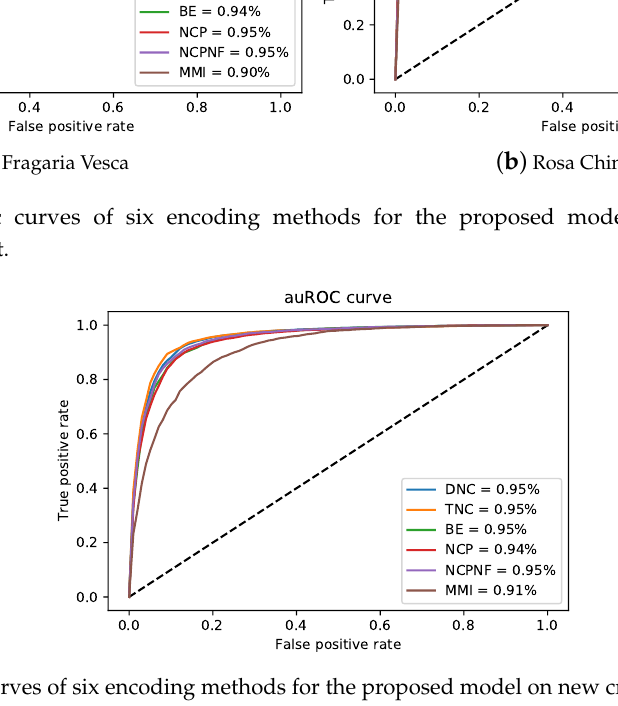
Figure 6. auRoc curves of six encoding methods for the proposed model on new cross-species training benchmark